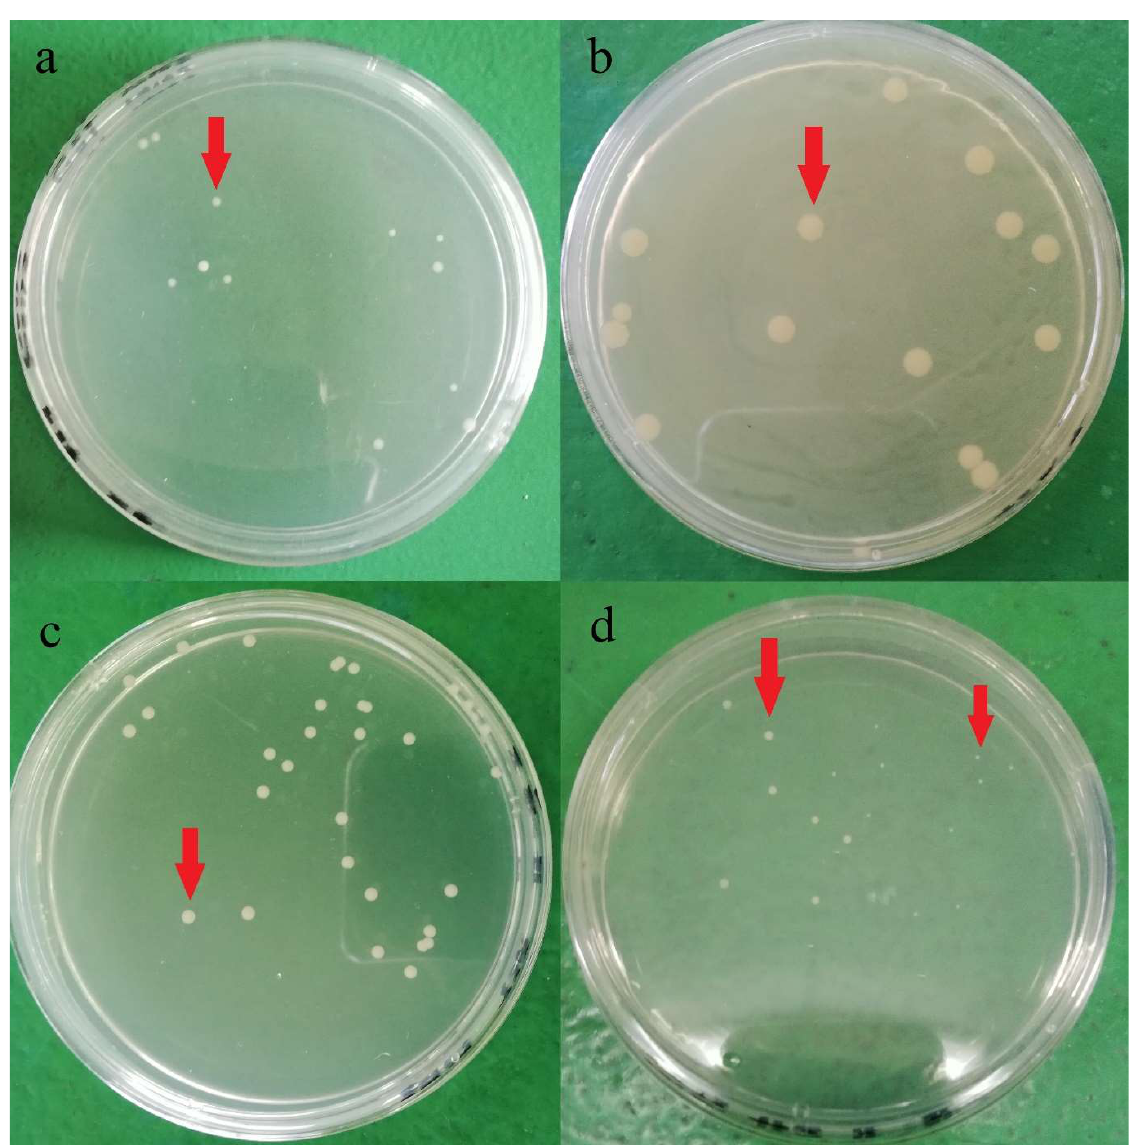
Figure 1. Different aerobic mesophilic bacteria colonies (red arrow) observed on plate count agar after 24 h incubation at 37 °C from a different brands of shell eggs: ( a ) brand A, ( b ) brand B, ( c ) Brand C, ( d ) Brand D.